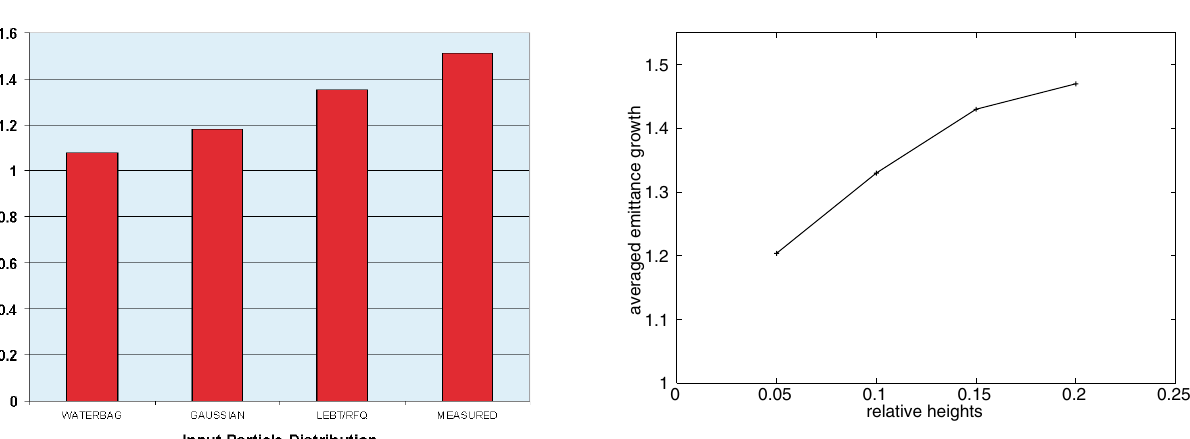
FIG. 10. (Color) A comparison of rms-emittance growth from simulations using three initial distributions with the measured experimental result for 1.5 breathing-mode mismatch.